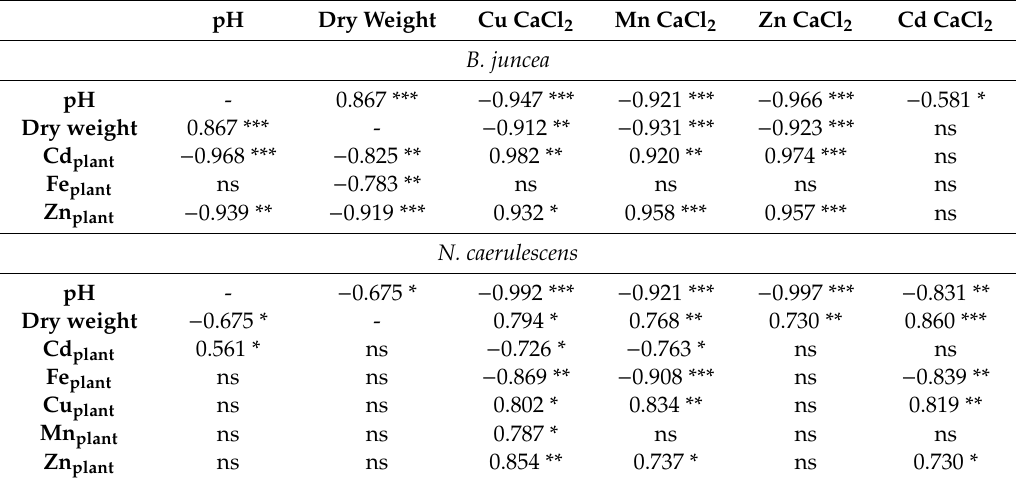
Table 4. Correlation matrix between the soil characteristics and the biomass and metal concentrations of the plants ( B. juncea and N. caerulescens ) from Experiment